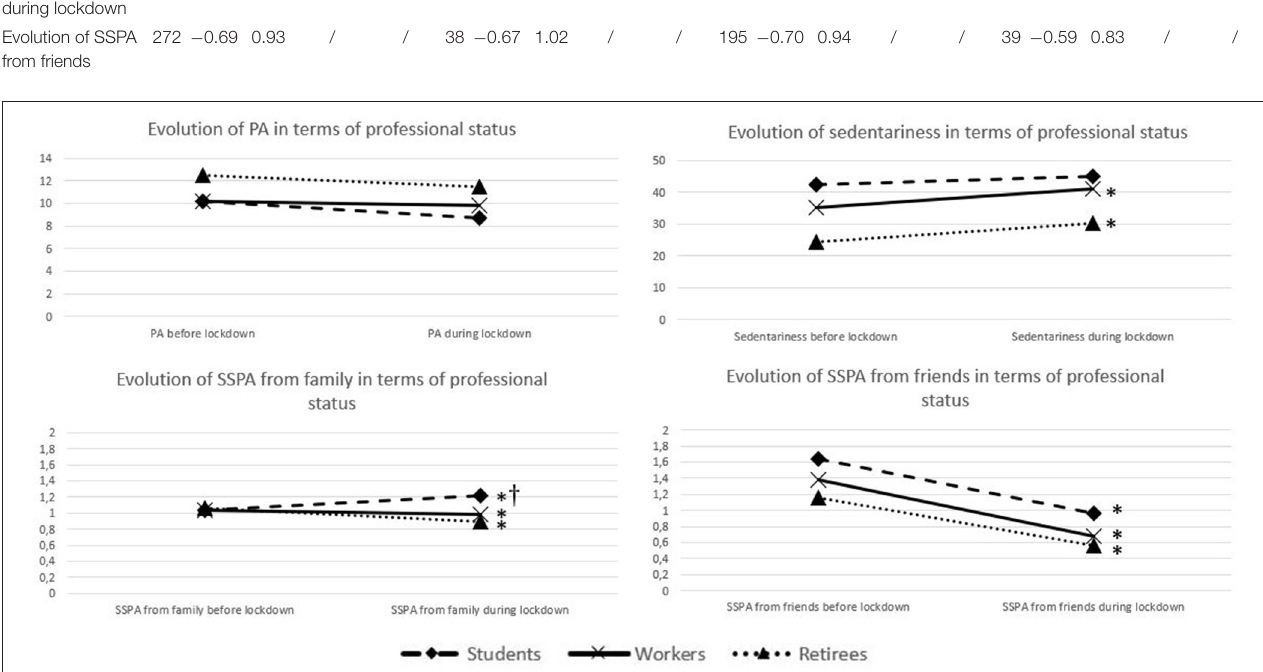
FIGURE 1 | Evolutions over time and comparisons in terms of professional statuses of PA, sedentariness, SSPA from family and SSPA from friends. *indicates significant differences between prior to and during lockdown ( P < 0.05). workers and retirees ( P < 0.05).